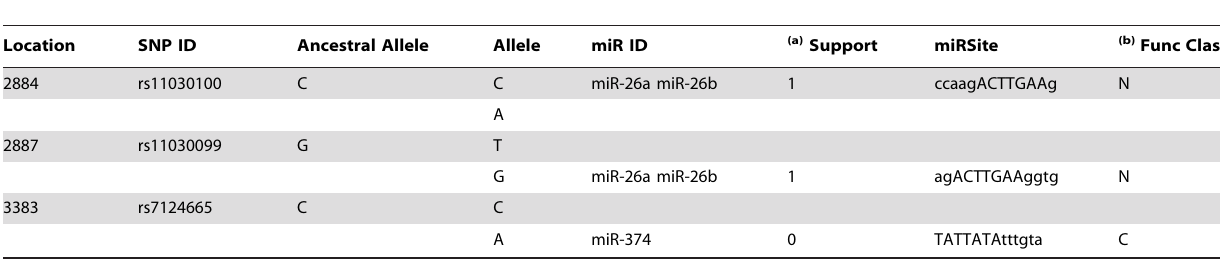
Table 1. SNPs that modify miRNA binding sites according to PolymiRTS Database.